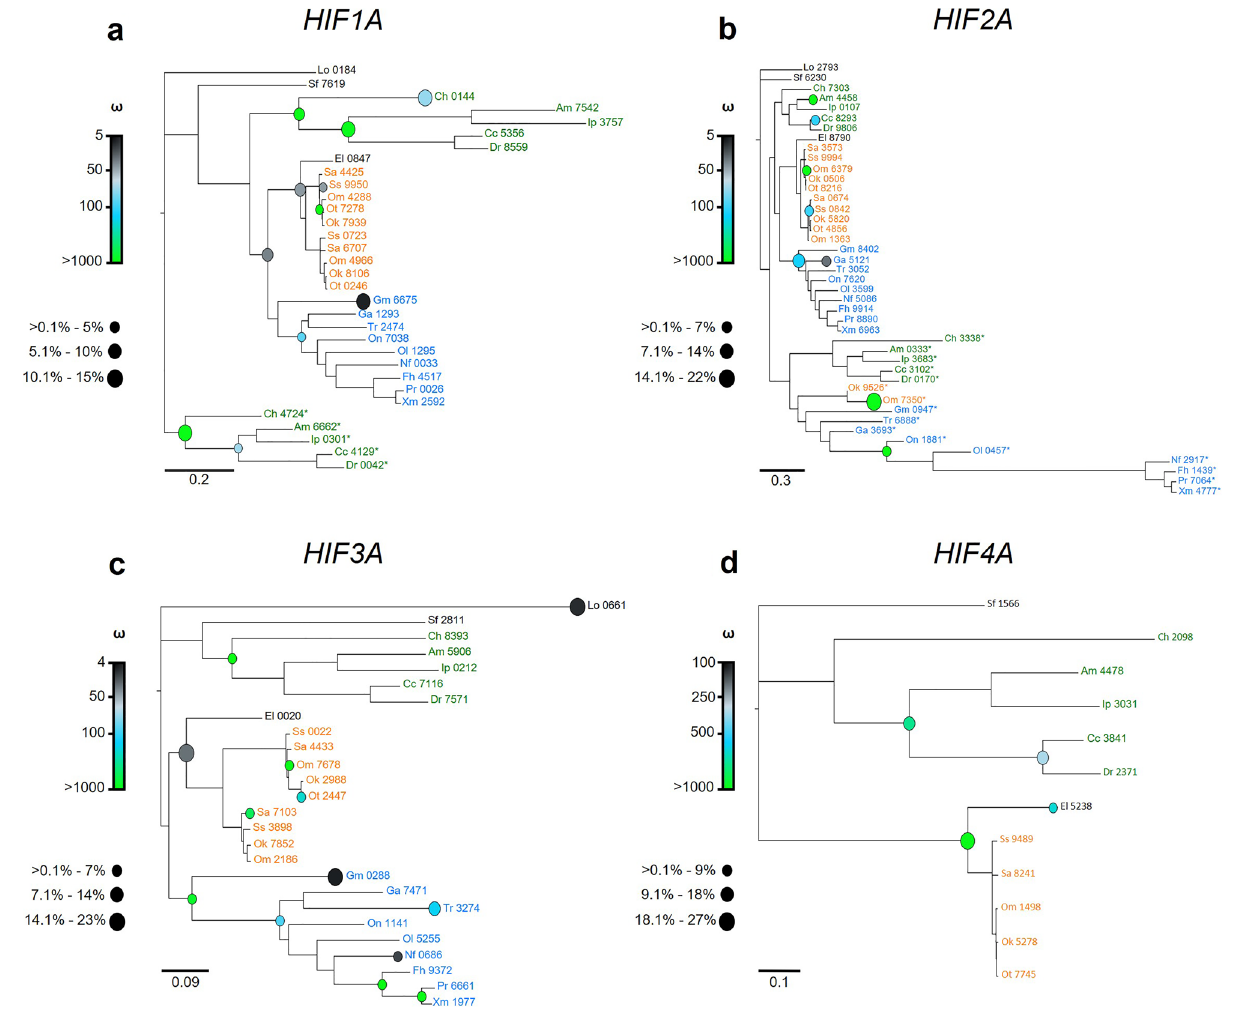
Figure 3. Positively selected branches in the evolution of actinopterygian ( a ) HIF1A , ( b ) HIF2A , ( c ) HIF3A , and ( d ) HIF4A . Branches were identified by adaptive branch-site random effects likelihood (aBSREL) tests for episodic diversification. The size of the circle represents the proportion of sites on branches significant for positive selection and the color gradient represents the magnitude of the positive selection ω rate class. For each HIFA paralog, taxa are color coded: Otocephala, green; Salmoniformes, orange; Neoteleostei, blue. The outgroup, Ciona intestinalis , basal actinopterygian (spotted gar, Lepisosteus oculatus ), basal teleost (Asian arowana, Scleropages formosus ), and sister taxa to Salmoniformes (Northern pike, Esox lucius ), are not color coded. Sequences are identified by the first letter of the genus and species followed by the last four digits of the NCBI or Ensemble reference gene accession number (see Supplemental Table S1 for a full list of genes). Teleost- specific duplicates HIF1Ab and HIF2Ab are designated by